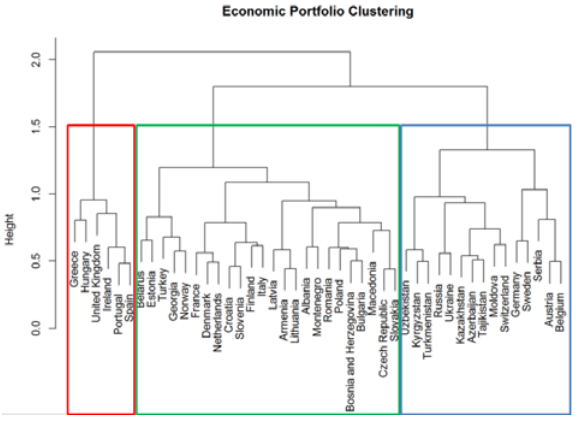
Figure 17. APD similarity scores hierarchical clusters.